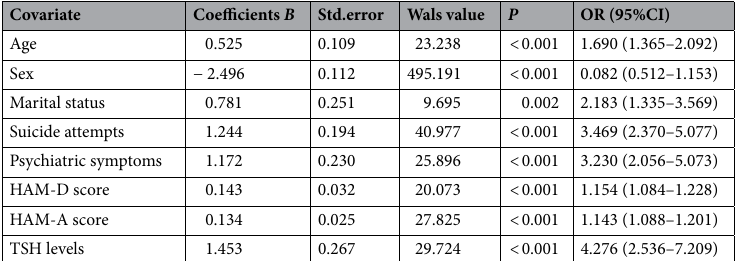
Table 3. Risk factors related to MetS by univariate binary logistic analysis.